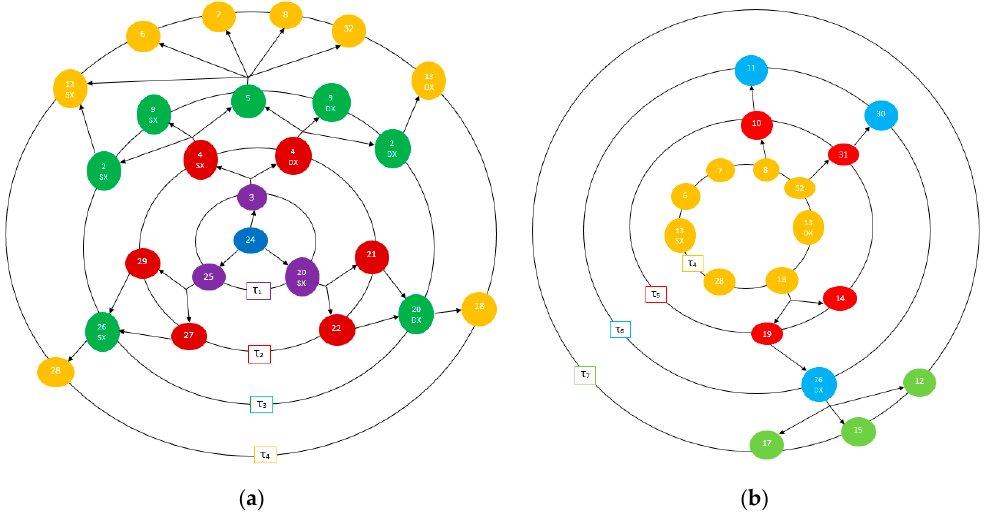
Figure 13. ( a , b ) Disassembly wave applied to the gearbox.